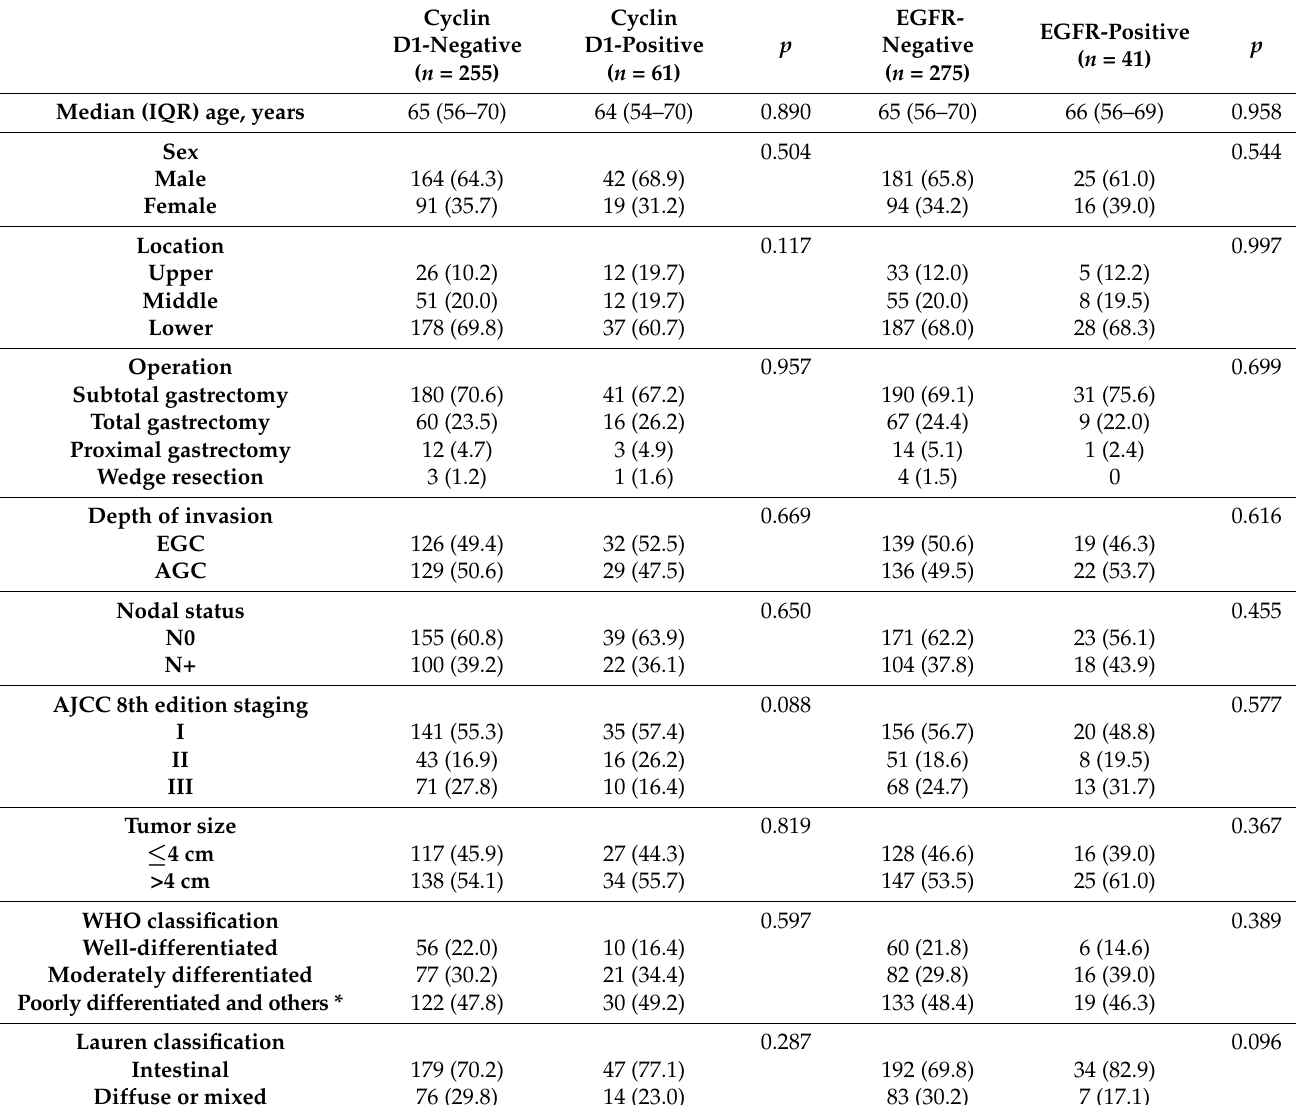
Table 1. Baseline characteristics of